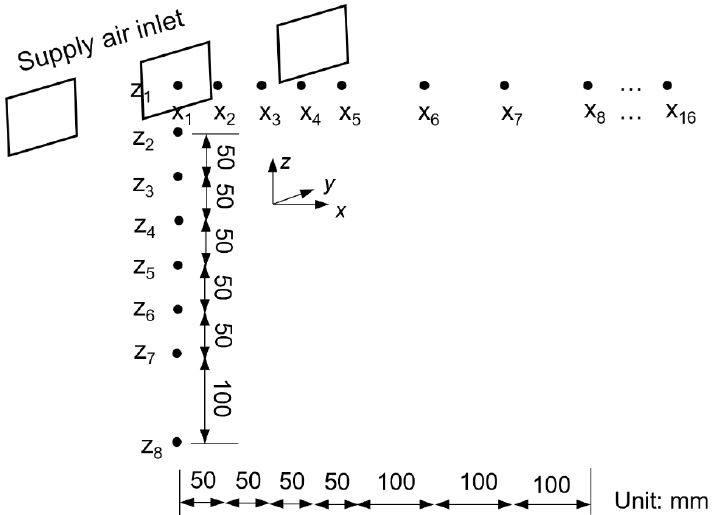
Figure 2. Layout plan of measurement points in center plane of multiple parallel jets.